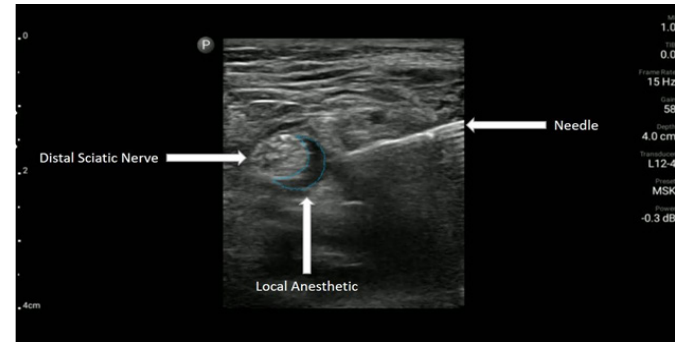
Image 2. Ultrasound image showing the distal sciatic nerve with surrounding local anesthestic and needle visualized using an in- plane